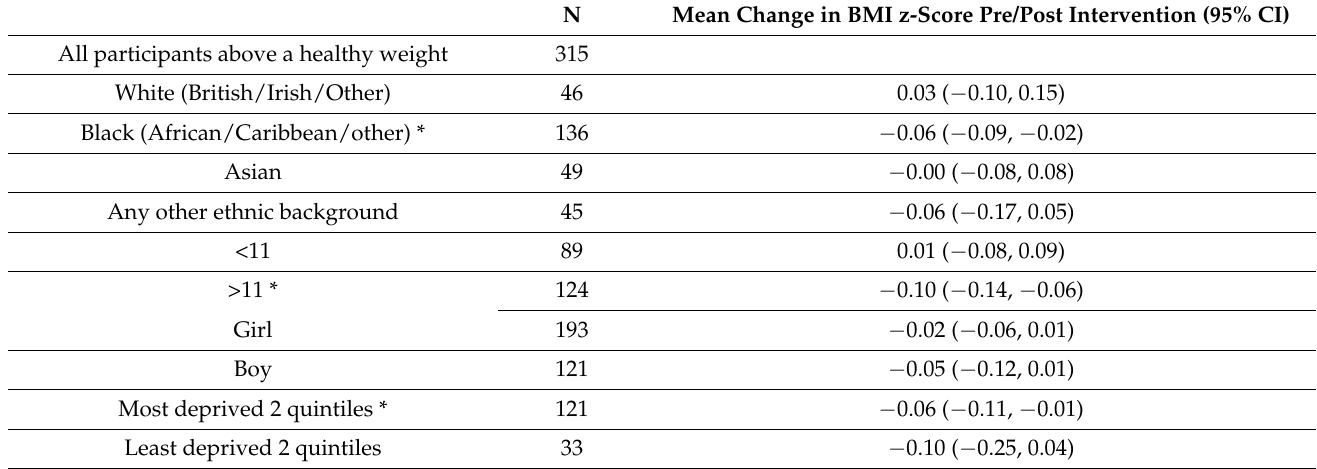
Table 3. Subgroup analysis of participants above a healthy weight by ethnicity, age, gender and level of deprivation. N Mean Change in BMI z-Score Pre/Post Intervention (95% CI) 315